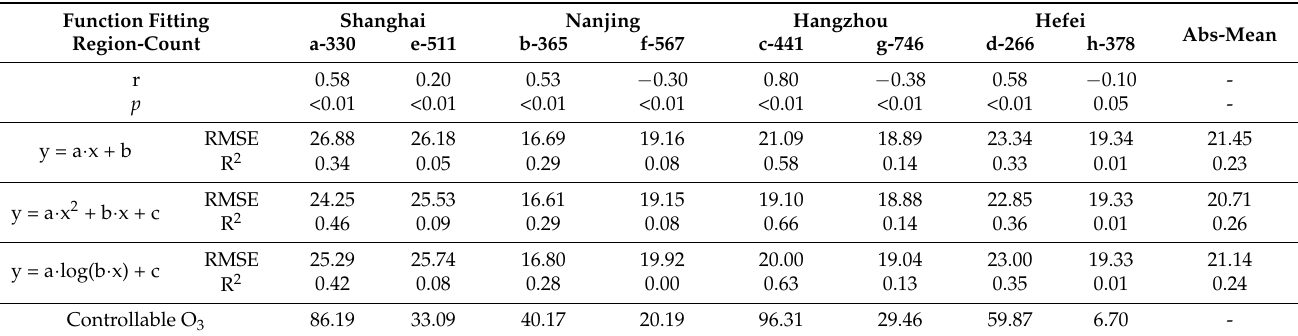
functions between ∆ O 3 and NO 2 , and the controllable O 3 related to NO 2 adjustment.